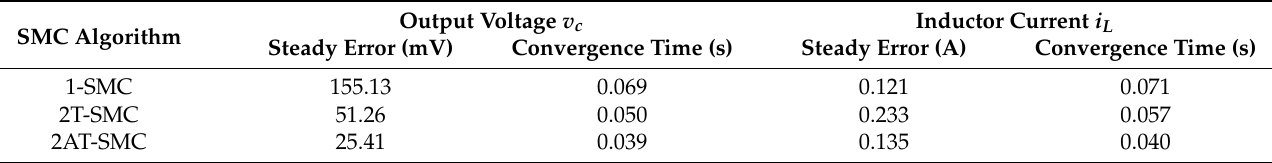
Table 4. Comparison of voltage and current in multi-disturbed working case.